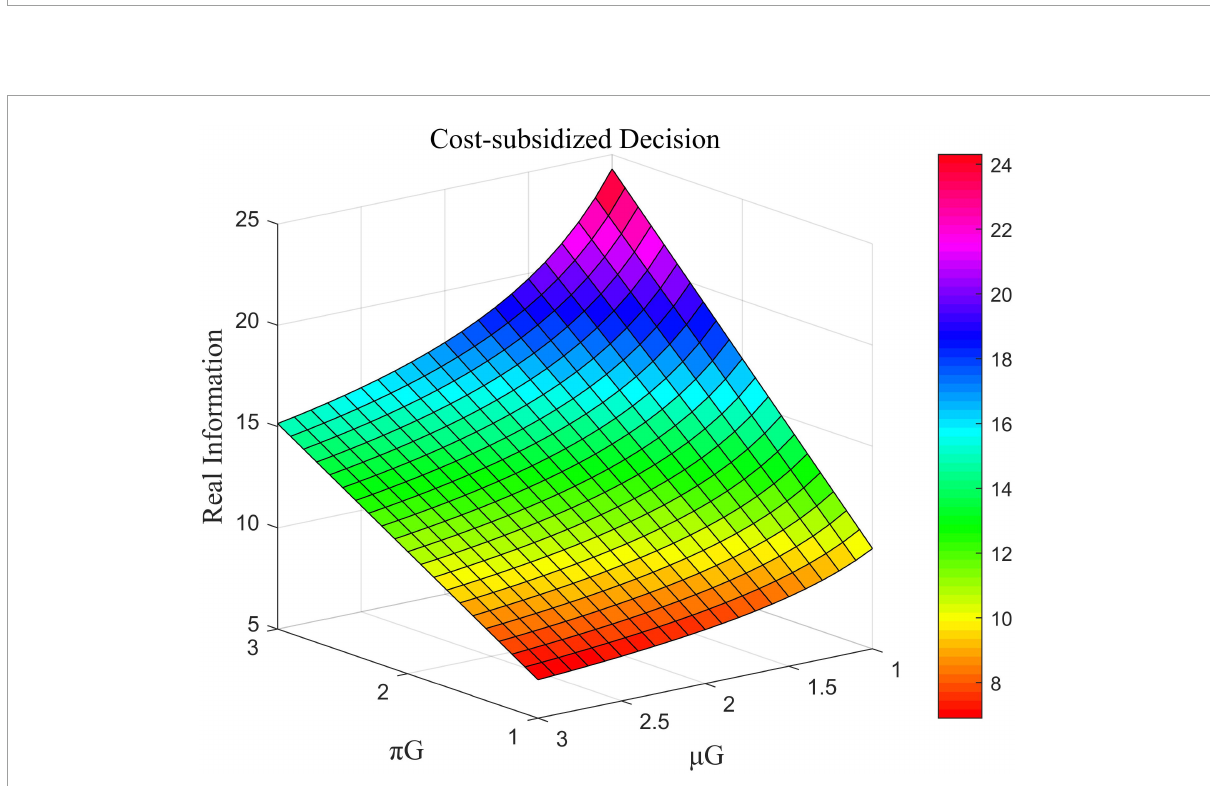
FIGURE8 Impact of π G and µ G on the total amount of real information under cost-subsidized